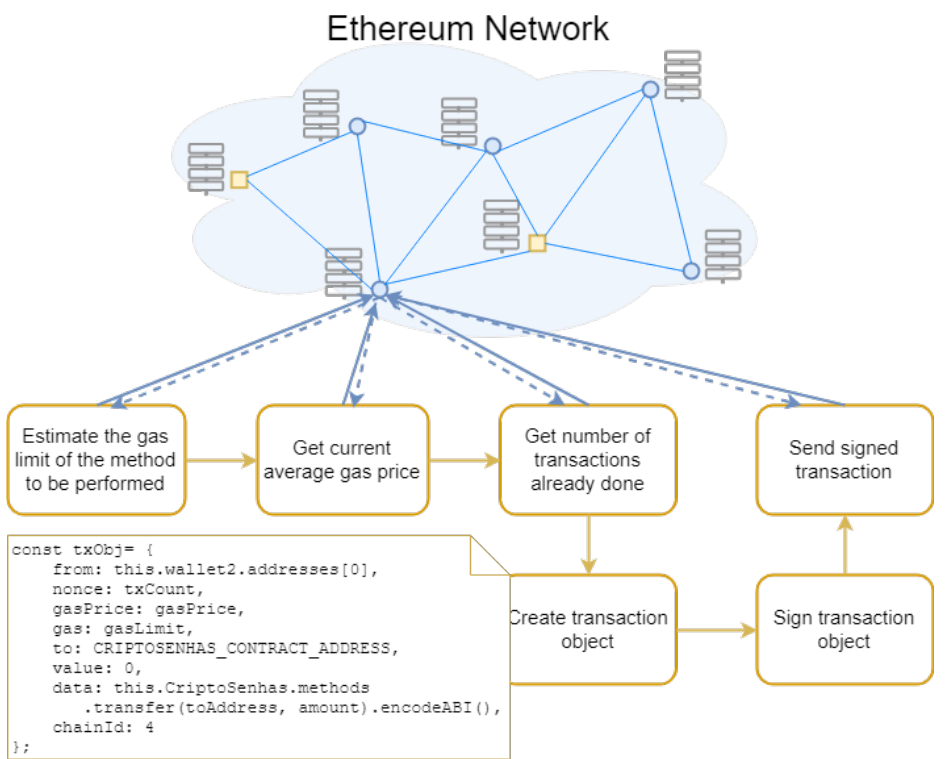
Figure 18. Execution flow to perform a transaction of meal vouchers.